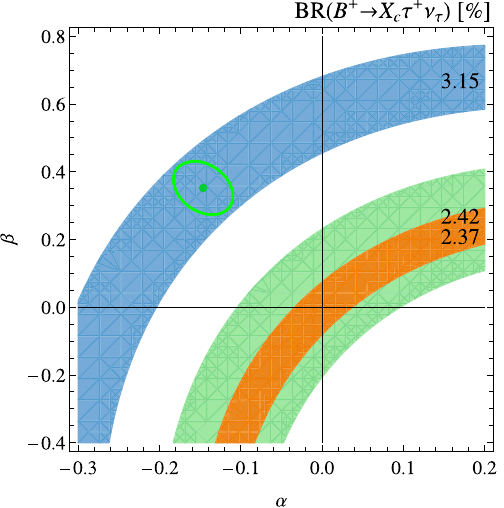
Fig. 6 Fit of the data to the parameters α and β . The green ellipse rep- resents the fit result to the exclusive channels, the green band represents the LEP measurement, the red band the SM result obtained form the